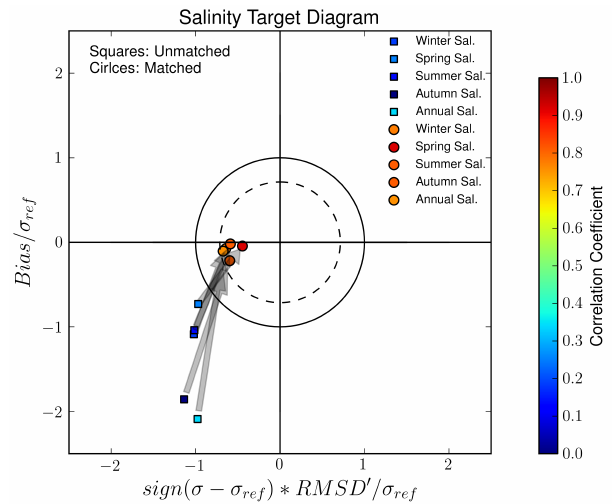
Fig. 19. Target diagram showing the impact of the transition from Fig.19. Targetdiagramshowingtheimpactofthetransitionfromtheunmatchedtothematchedmethods on temperature. the unmatched to the matched methods on temperature.